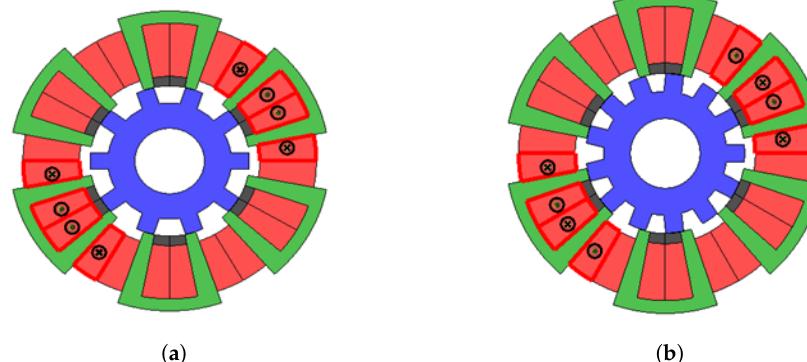
Figure 6. Armature coil “A” configuration. ( a ) 10-rotor pole. ( b ) 13-rotor pole.